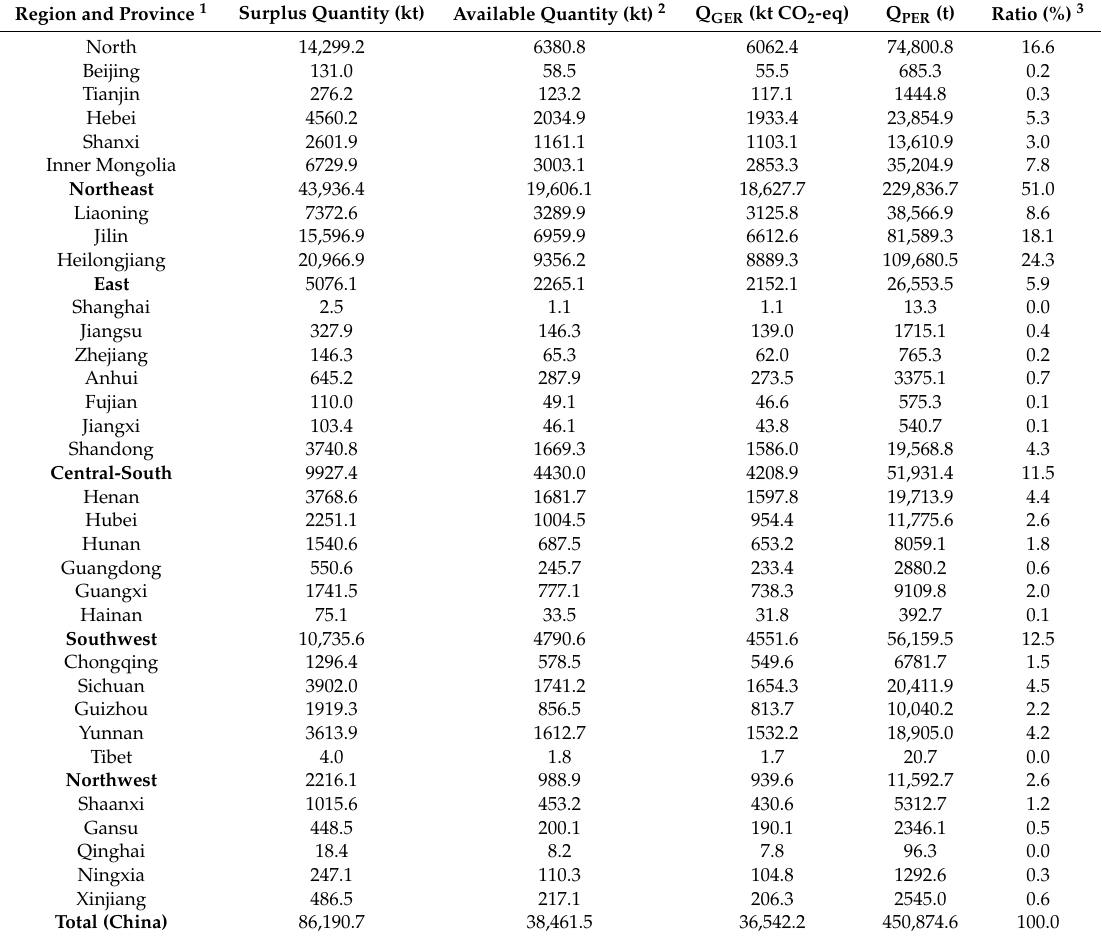
Table 7. Geographical distributions of corn stover surplus, availability for bioethanol production, and potential total emission reductions in GHG (Q GER ) and PM 2.5 (Q PER ) from corn stover-based bioethanol compared with the reference case in di ff erent regions and provinces in